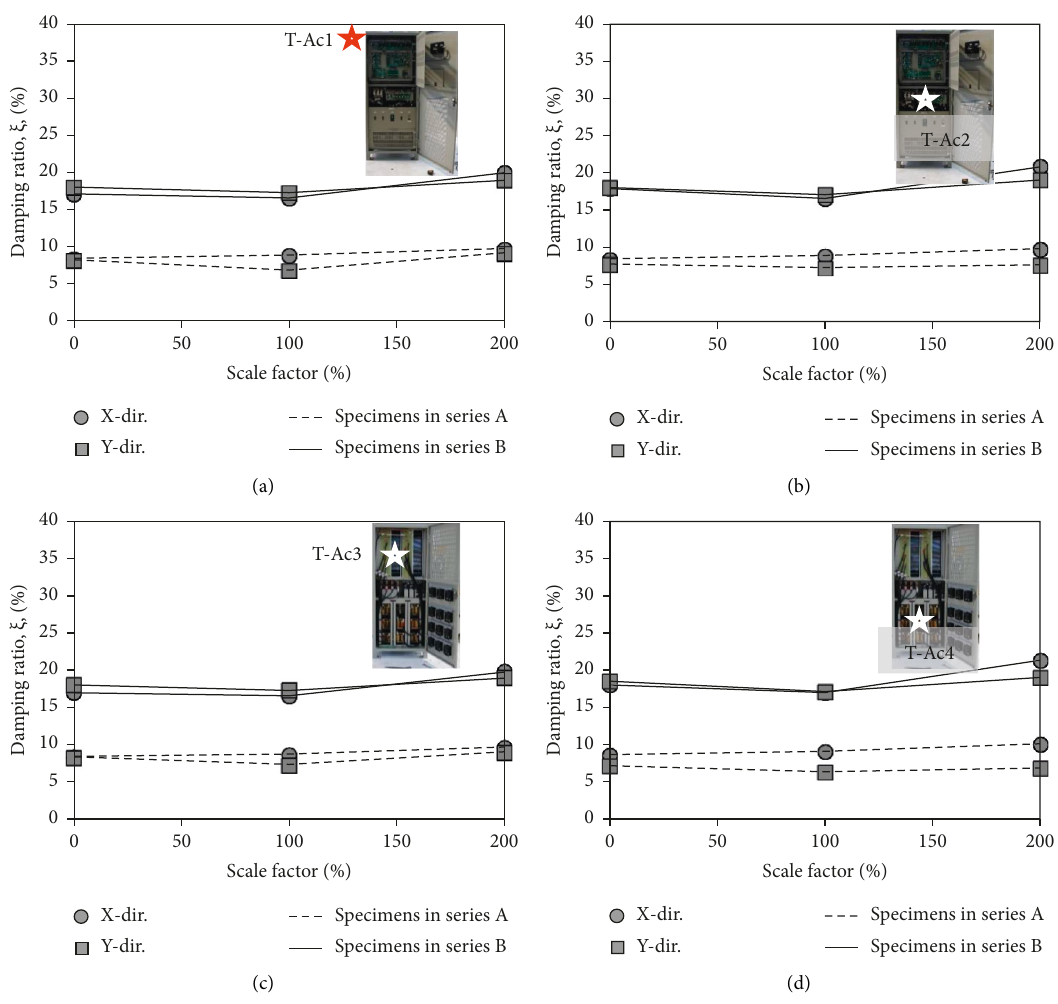
Figure 12: Damping ratio versus scaling factor of the test specimens at different locations: (a) at the top of the UPS, (b) at the control switch, (c) at the cooling system, and (d) at the